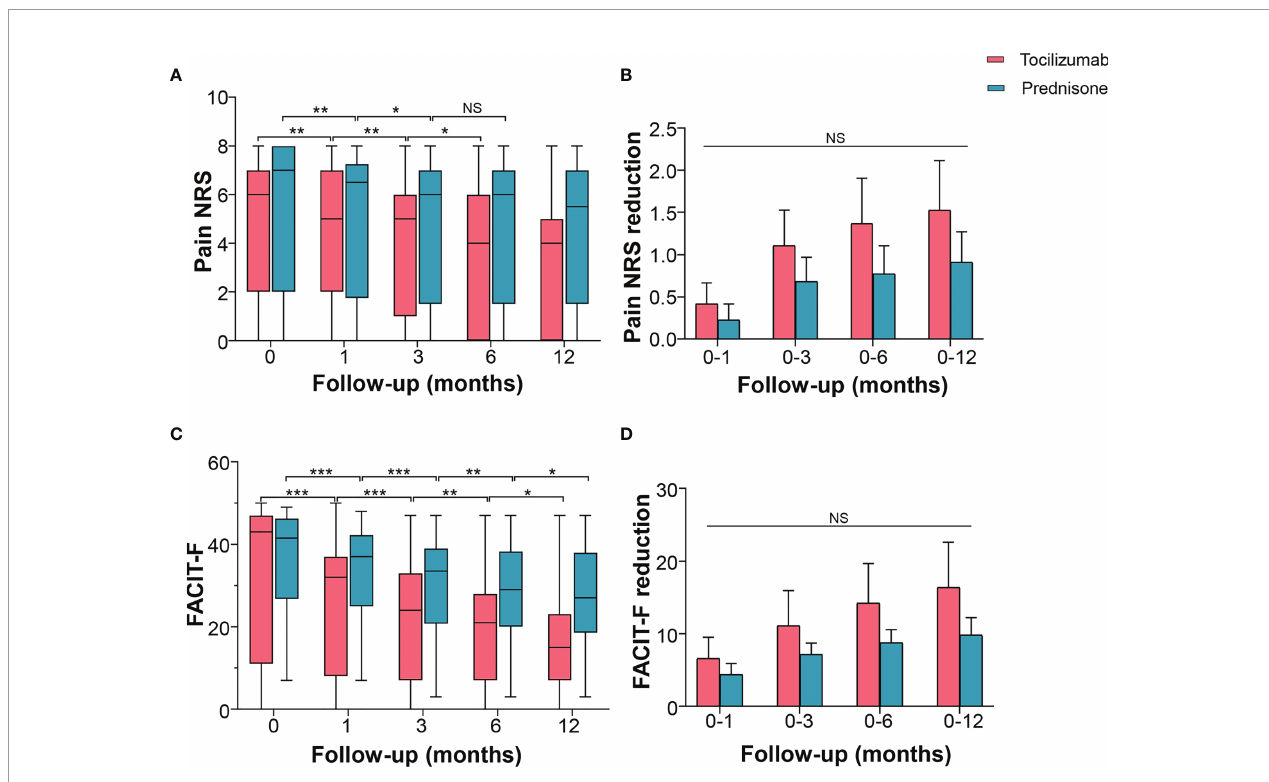
FIGURE 3 | Effects of tocilizumab and prednisone on pain and fatigue. (A) Pain NRS changes at baseline, 1 month, 3 months, 6 months, and 12 months in patients receiving tocilizumab and prednisone. (B) Pain NRS reduction rate was compared between the two groups. (C) FACIT-F score changes at the baseline, 1 month, 3 months, 6 months, and 12 months in patients receiving tocilizumab and prednisone. (D) Comparisons of FACIT-F reduction rate between the two groups. FACIT-F: Functional Assessment of Chronic Illness Therapy-Fatigue Scale; NRS: numerical rating scale. * p < 0.05; ** p < 0.01; *** p < 0.001; NS, not signi fi